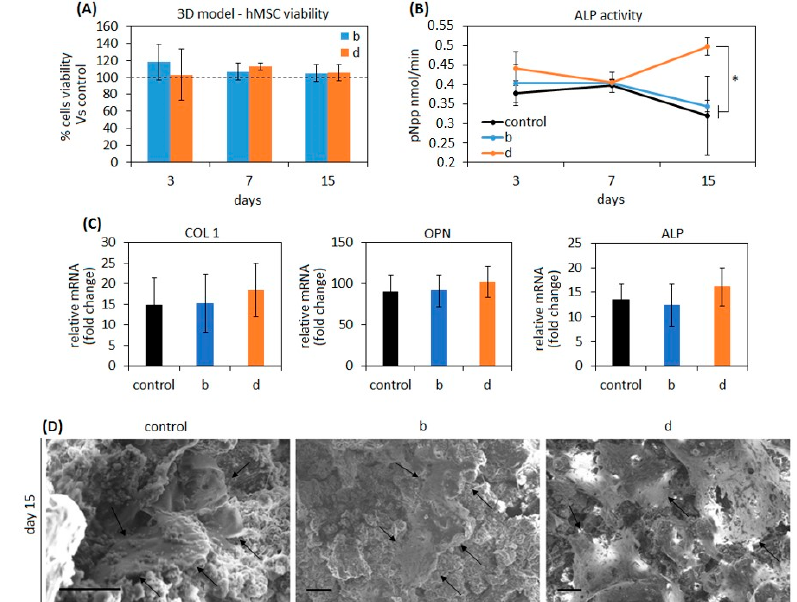
Figure6. Osteogenicproperties. Compositeresultsascytocompatibleforpore3Dseeding( A )displaying values higher than the 100% value related to day 0 seeding (indicated by the dashed line) as well as they successfully supported hMSC osteogenic di ff erentiation that was verified by alkaline phosphatase (ALP, B , * p < 0.05 sample d vs. b and control) increasing release in the medium and osteogenic genes collagen 1 (COL 1), osteopontin (OPN), and ALP ( C ) upregulation over the seeding day expression (fold change). Finally, SEM images ( D ) confirmed that cells grown within pores reached the osteoblast-like stellate morphology after 15 days cultivation (indicated by the arrows). SEM